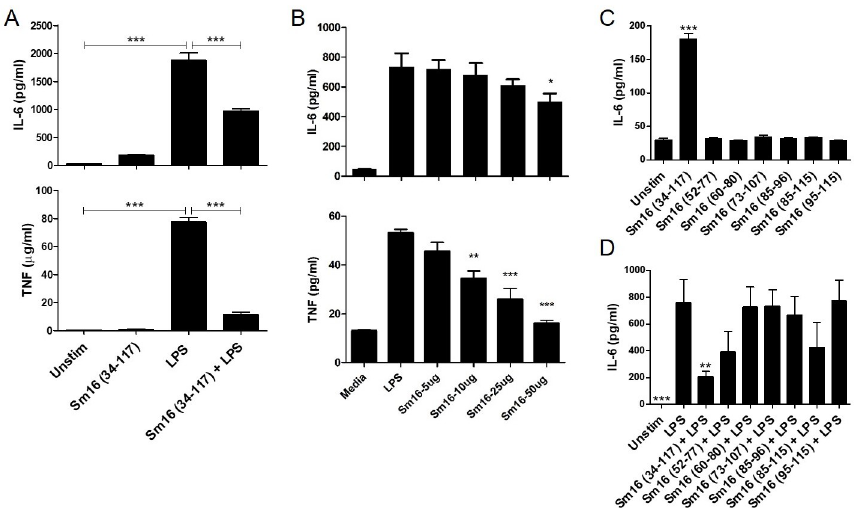
Fig 6. Effects of synthetic peptide Sm16 (34–117) treatment on cytokine secretion by macrophages. ( A ) IL-6 and TNF in cell supernatants of THP-1 macrophages (2.5 x 10 5 ) treated with Sm16 (34–117) (20 μ g/ml), LPS (100 ng/ml) and Sm16 (34–117) + LPS for 16 hrs were quantified by ELISA. Data derived from three independently performed experiments was analysed using repeated measures ANOVA with Tukey’s multiple comparison test. ( B ) Sm16 (34– 117) inhibits macrophage activation in a dose-dependent manner. Bone marrow derived macrophages (5.0 x 10 5 ) from Balb/c mice were incubated for 30 min with full-length Sm16 (34–117) (5–50 μ g/ml) and after washing in PBS